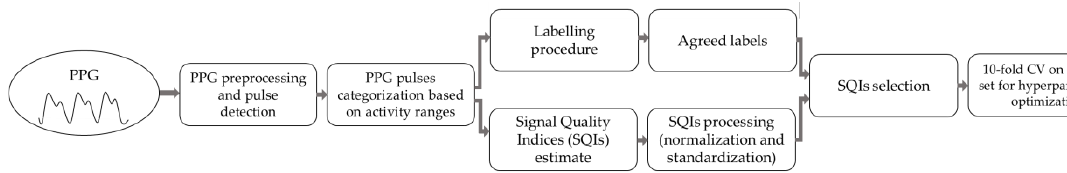
Figure 5. Signal processing and classification pipeline.